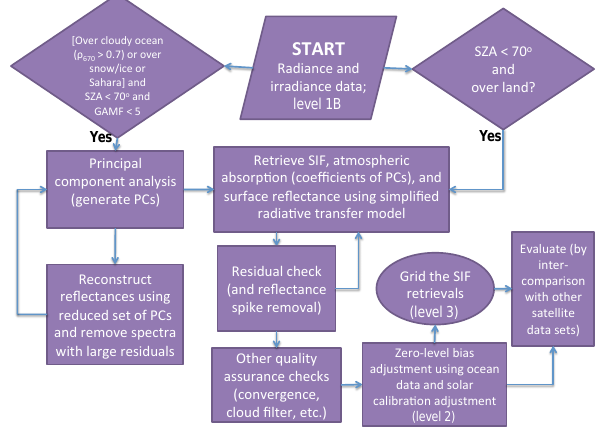
Figure 3. Flow diagram of the basic steps used to produce SIF data